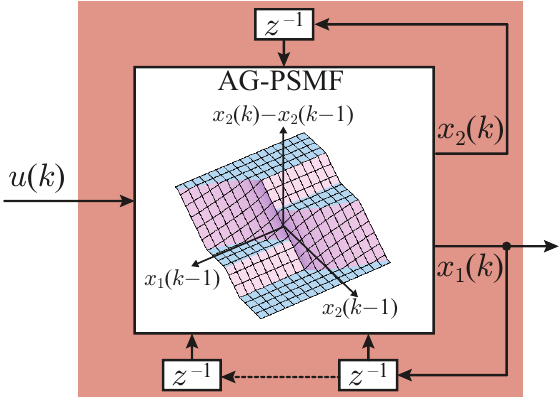
Figure 6. Block diagram of AG-PSMF.